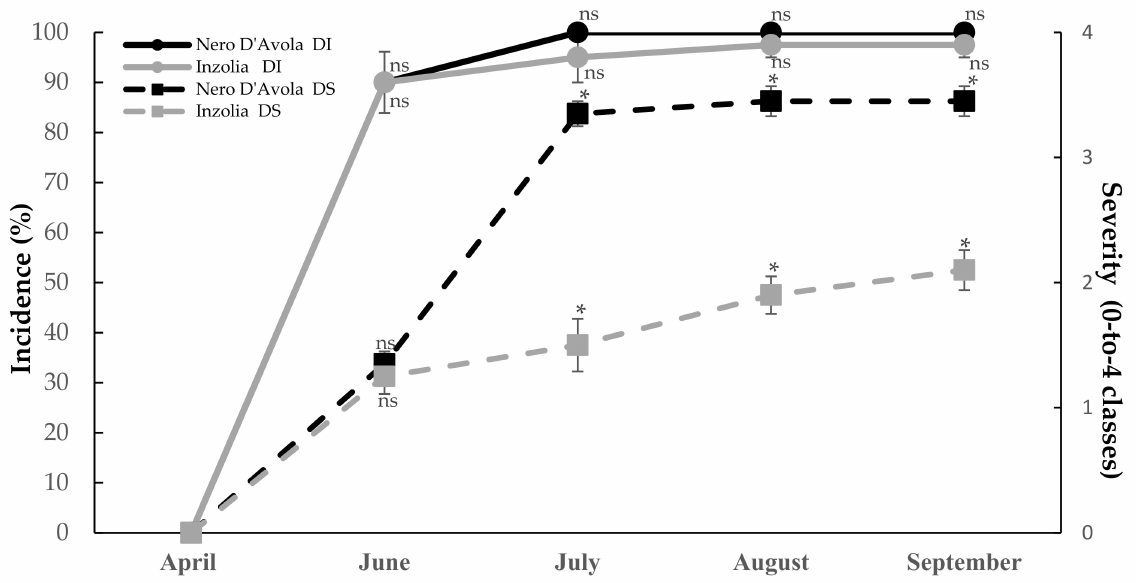
Figure 5. Progression over time of powdery mildew infections caused by Erysiphe necator in control plots of vineyards. Continuous lines indicate dual comparisons of DI progression val- ues (percent) over time whereas dotted lines show dual comparisons of DS progression values (0-to-4 scale) over time between Nero d’Avola (black lines) and Inzolia (grey lines). ns = not significant; * = significant